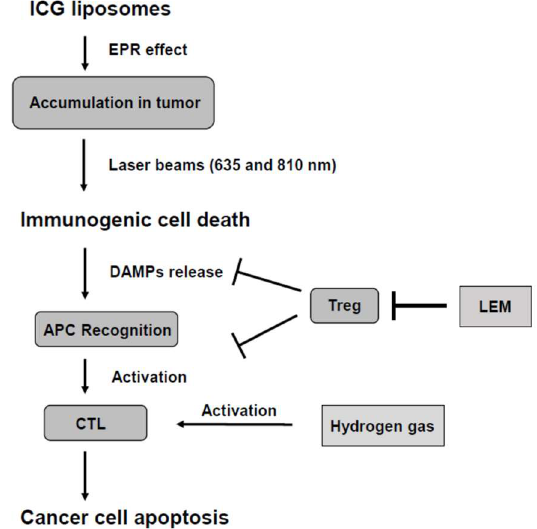
Figure 4. Mechanism of PDT using ICG liposomes. ICG; indocyanine green, EPR; enhanced permeability and retention, DAMPs; damage-associated molecular patterns, Treg; regulatory T-lymphocyte, LEM; Lentinura edodes mycelium, APC; antigen-presenting cell, CTL; cytotoxic T-lymphocyte.